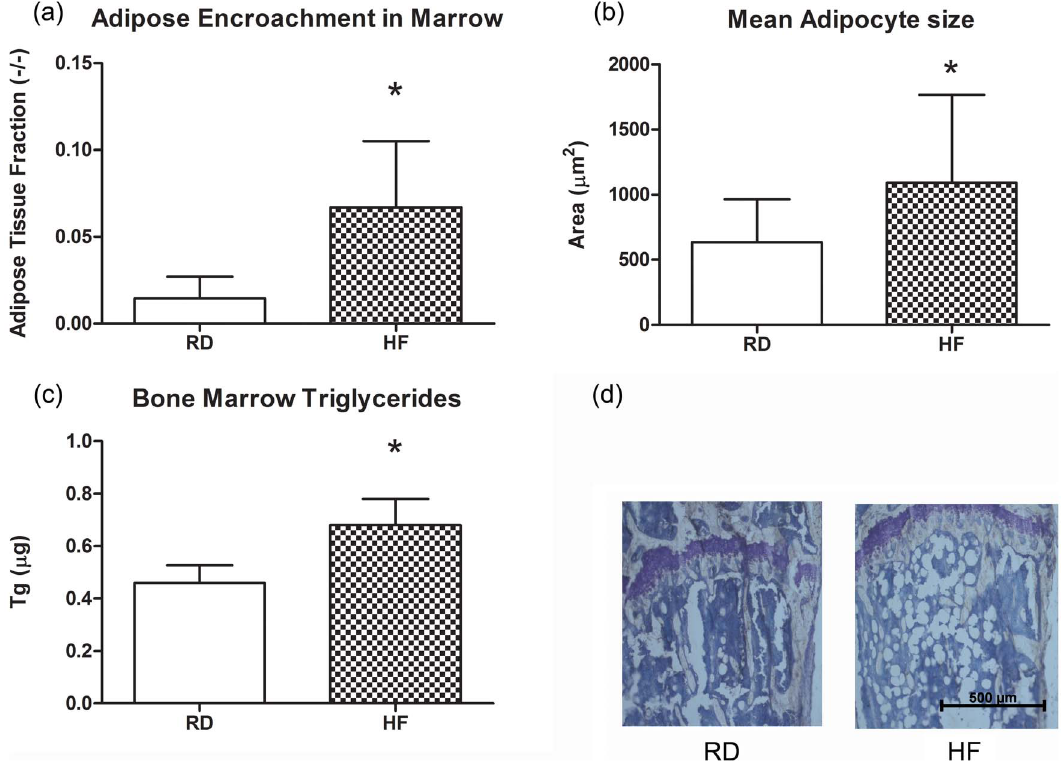
Figure 2. Six Weeks of HFD Rapidly Remodels the Bone Marrow Towards Adiposity. (a,b,d) The percentage of BM space taken up by adipose tissue, as assessed by histology, increased by almost 4 fold in HFD animals compared to control, an increase at least partially due to increasing adipocyte size (n=6). (c) This leads to an increase in BM triglyceride storage (n=10). The inclusion of adipocytes in the BM is significant because of the deleterious paracrine and inflammatory consequences adipocytes are thought to present to hematopoiesis. Additionally, BM adiposity in general represents a decline in BM quality and health, as is demonstrated by increased BM adiposity in osteoporosis and anorexia nervosa. * P , 0.05 vs.